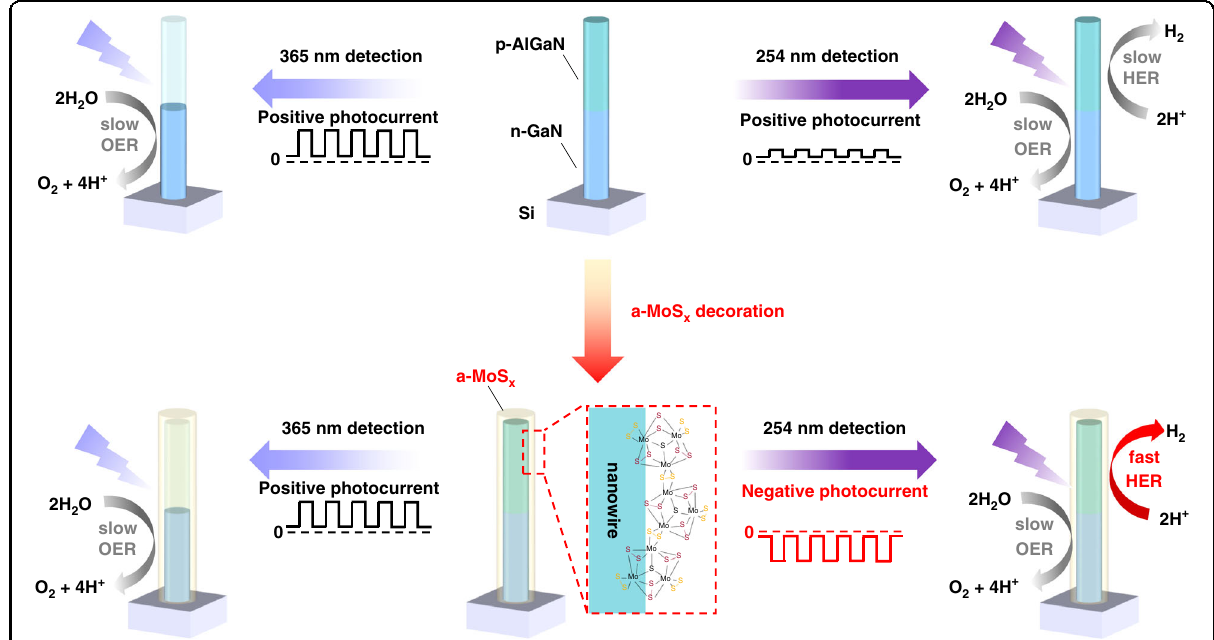
Fig. 1 Operation of the nanowire-based spectrally distinctive photodetector. Schematic illustration of the nanowire structures, operation of nanowire-based photoelectrochemical photodetectors under different light illumination and the corresponding chemical reaction process at nanowire surface: Top: p-AlGaN/n-GaN nanowire; Bottom: a-MoS x decorated p-AlGaN/n-GaN